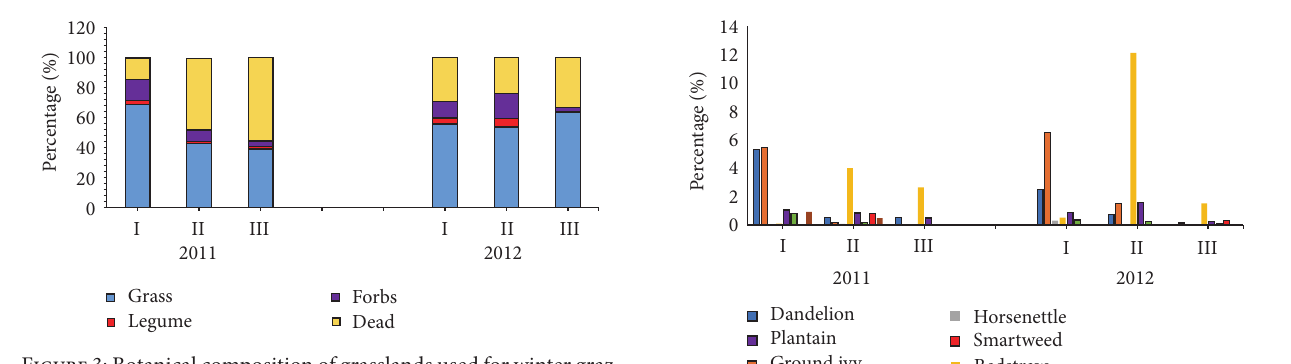
Figure 3: Botanical composition of grasslands used for winter graz- ing in three consecutive grazing intervals (I, II, and III)at Reedsville, WV. Grazing Interval: I = naturalized permanent grazingland, II = orchardgrass cultivated pastureland, and III = tall fescue cultivated pastureland.